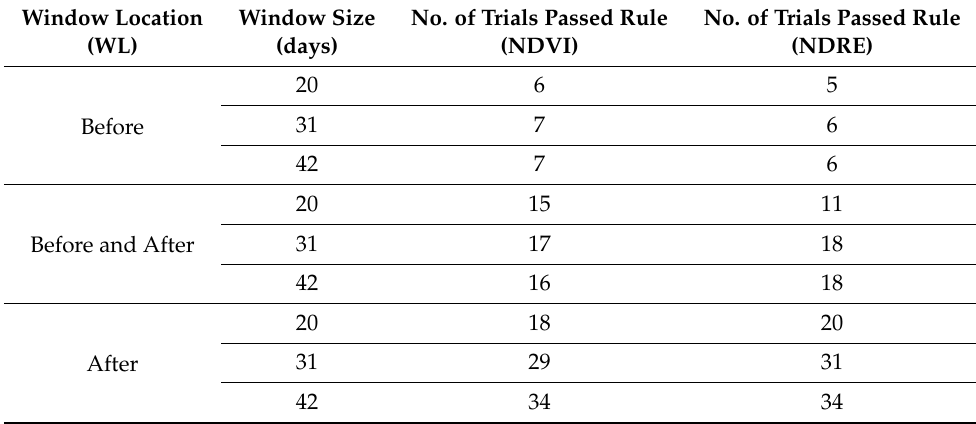
Table 6. Experiment results representing the number of trials that passed the condition mentioned in Equation (5) in relation to the window